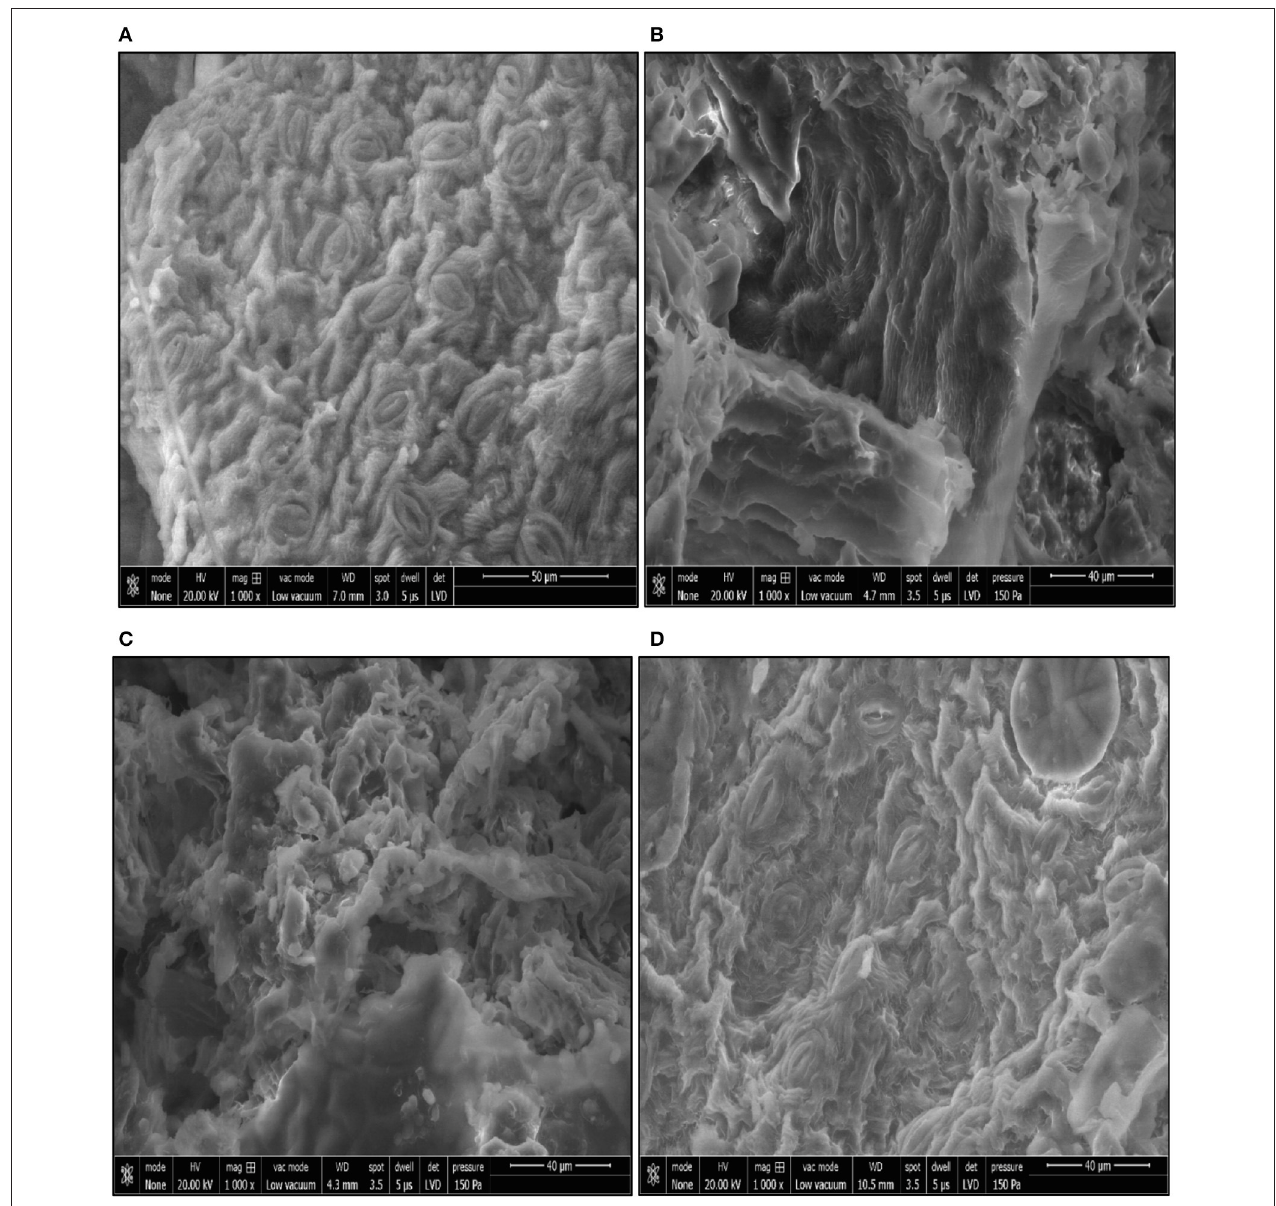
FIGURE 14 | The SEM images of (A) Untreated OFMSW, (B) OFMSW-30, (C) OFMSW-60, and (D)